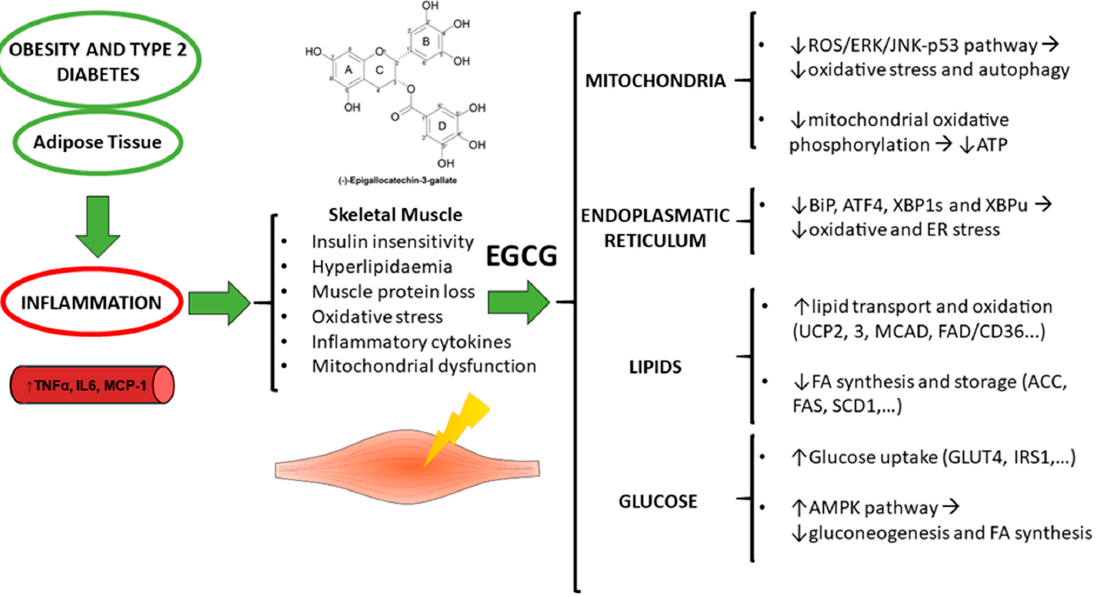
Figure 2. Summary of the effects of ( − )-Epigallocatechin-3-gallate on the modulation of muscle homeostasis in obesity and type 2 diabetes. Arrows indicate an increase ( ↑ ) or decrease ( ↓ ) of that particular molecule or the pathway’s activity.